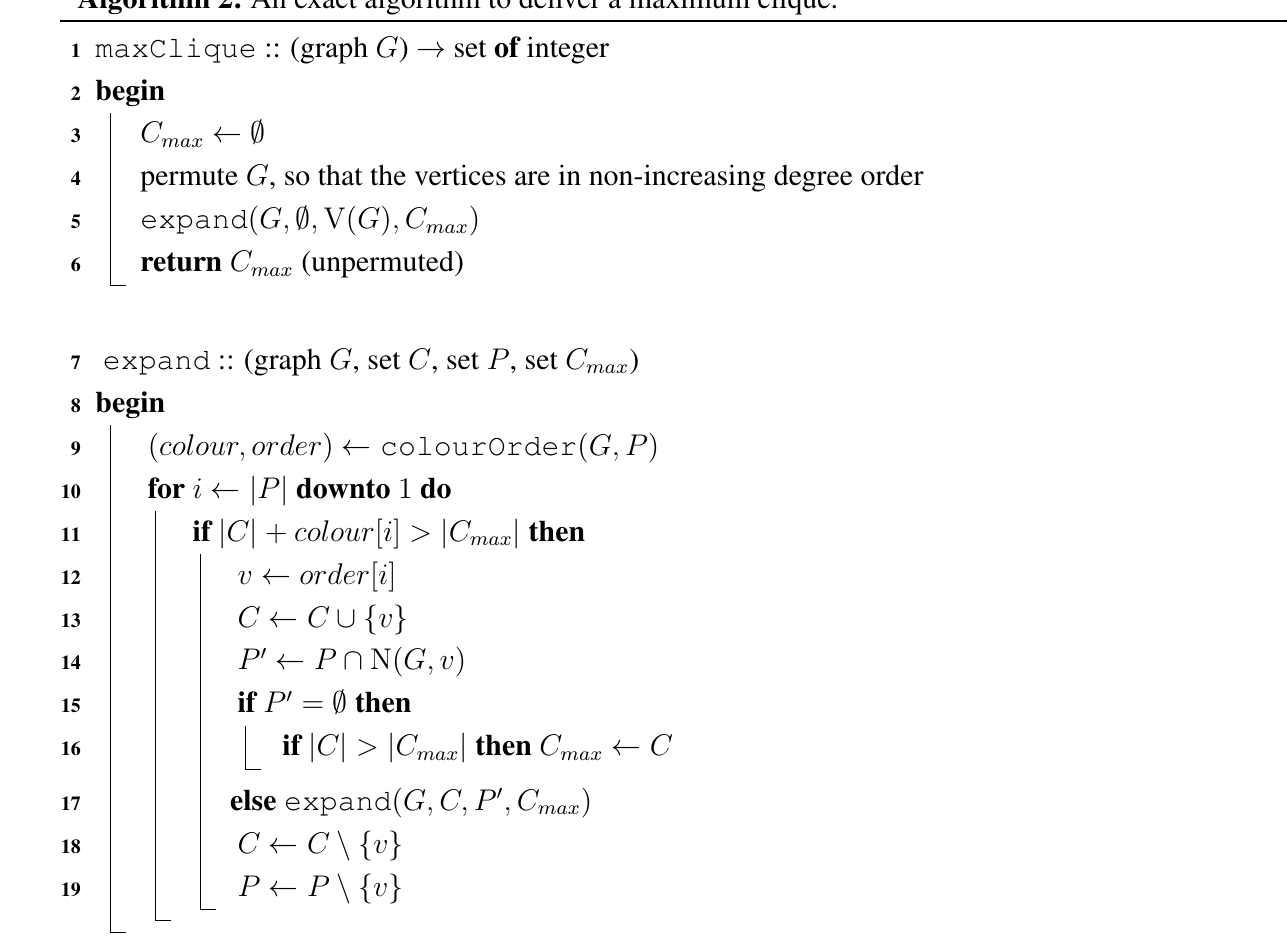
Algorithm 2: An exact algorithm to deliver a maximum